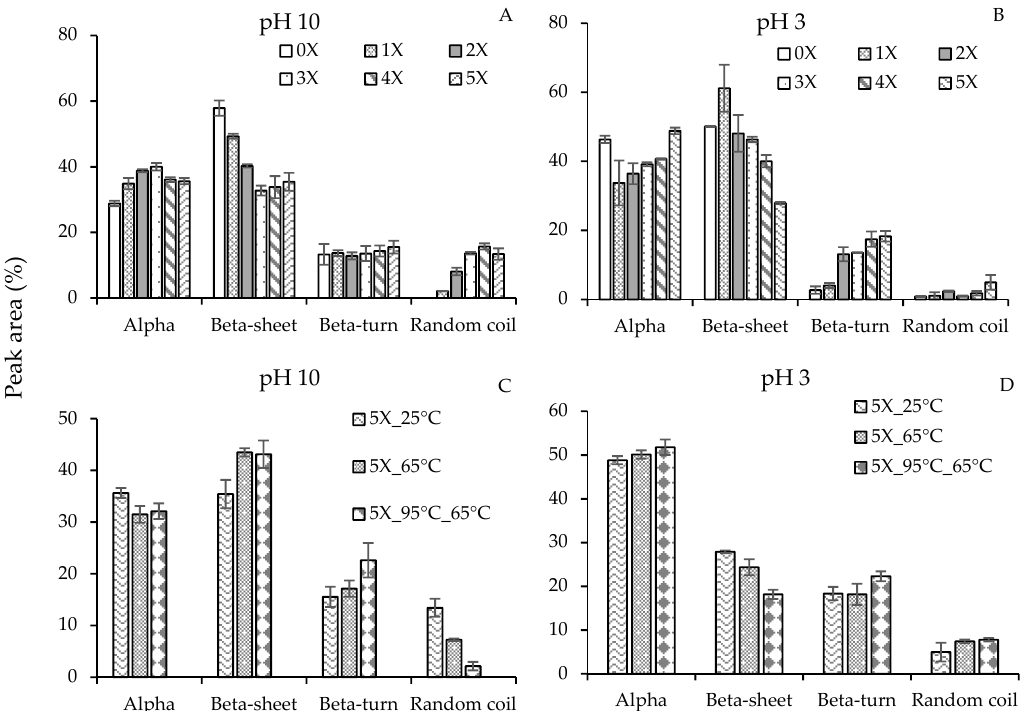
Figure 4. Estimation of secondary structure contents (%) of ethanol-induced pea proteins nanoparticles at ( A , C ) pH 10 and ( B , D ) pH 3 at 25 ° C by FTIR-analysis as a function of different ( A , B ) desolvation ratios (ethanol : protein) and ( C , D ) desolvation temperatures.